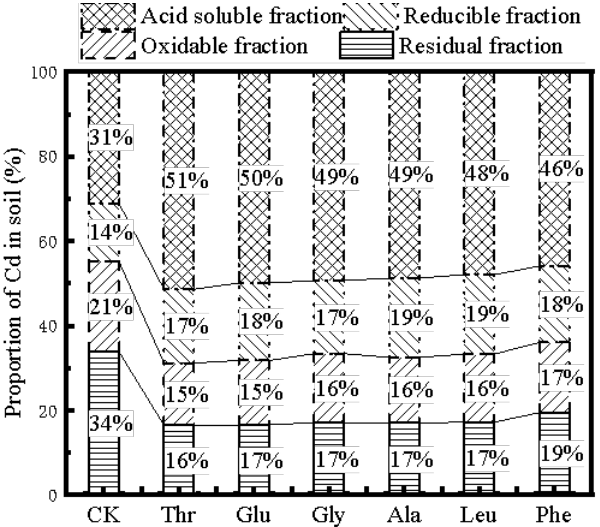
Figure 8. The Cd fraction in the contaminated soil using the BCR sequential extraction method.